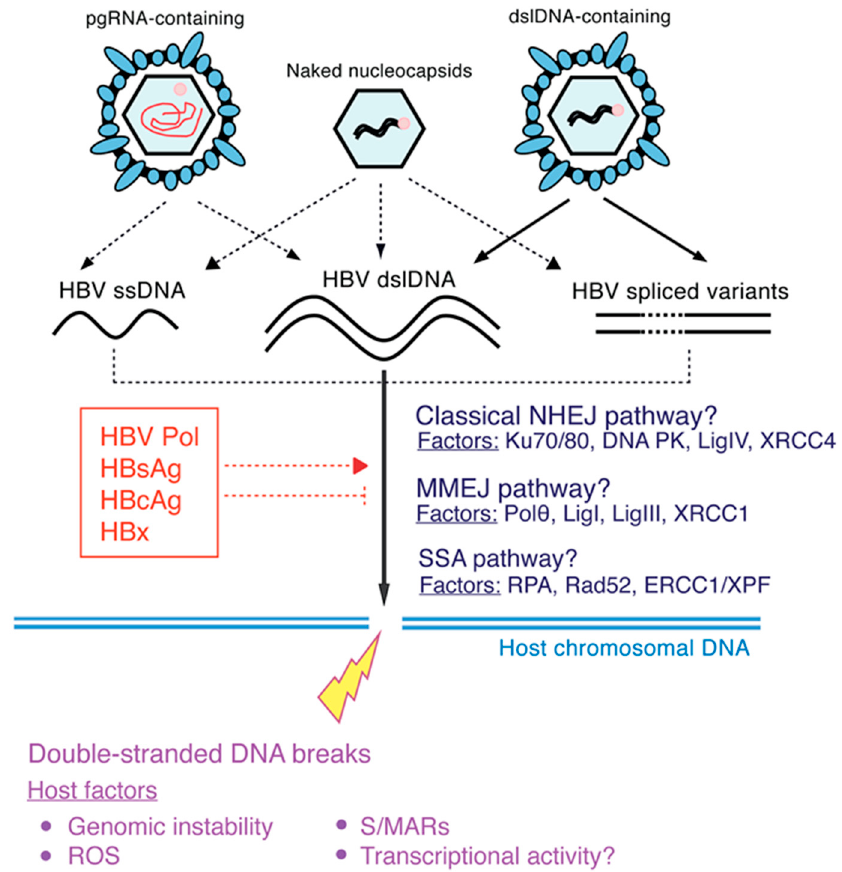
Figure 4. A model of potential molecular factors in HBV DNA integration. Various secreted HBV forms ( top row ) may be involved in bringing the potential molecular substrates for HBV DNA integration ( black ) into the cell. Both reported ( solid arrows ) and as-yet purely hypothetical pathways ( dashed arrows ) for HBV DNA integration into the host cell genome ( light blue double lines ) via potential cellular double-stranded DNA (dsDNA) repair mechanisms ( dark blue ) are shown, depicted with the key host enzymes involved. The substrates for integration include full-length HBV dslDNA, though the HBV single-stranded DNA (ssDNA) and spliced variant dsDNA forms may also contribute. Further, it is currently unknown whether viral proteins ( red ) play either an inhibitory or inducing role in HBV DNA integration. Integration occurs at dsDNA breaks in the host cell genome, and relevant host factors that induce these breaks are shown in purple. MMEJ, microhomology-mediated end-joining; NHEJ, non-homologous end-joining; SSA, single-stranded annealing; ROS, reactive oxygen species; S/MARs, scaffold/matrix attachment regions.